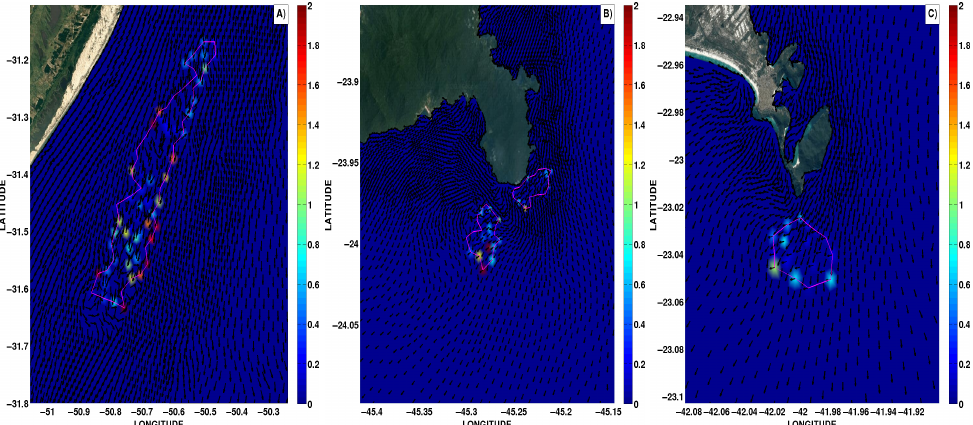
Figure 2. Mean power (kW · day − 1 ) of turbines at each site for the 10 − year simulation: ( A ) RS, ( B ) SP, and ( C ) RJ. Magenta lines represents the boundary contour of the turbines